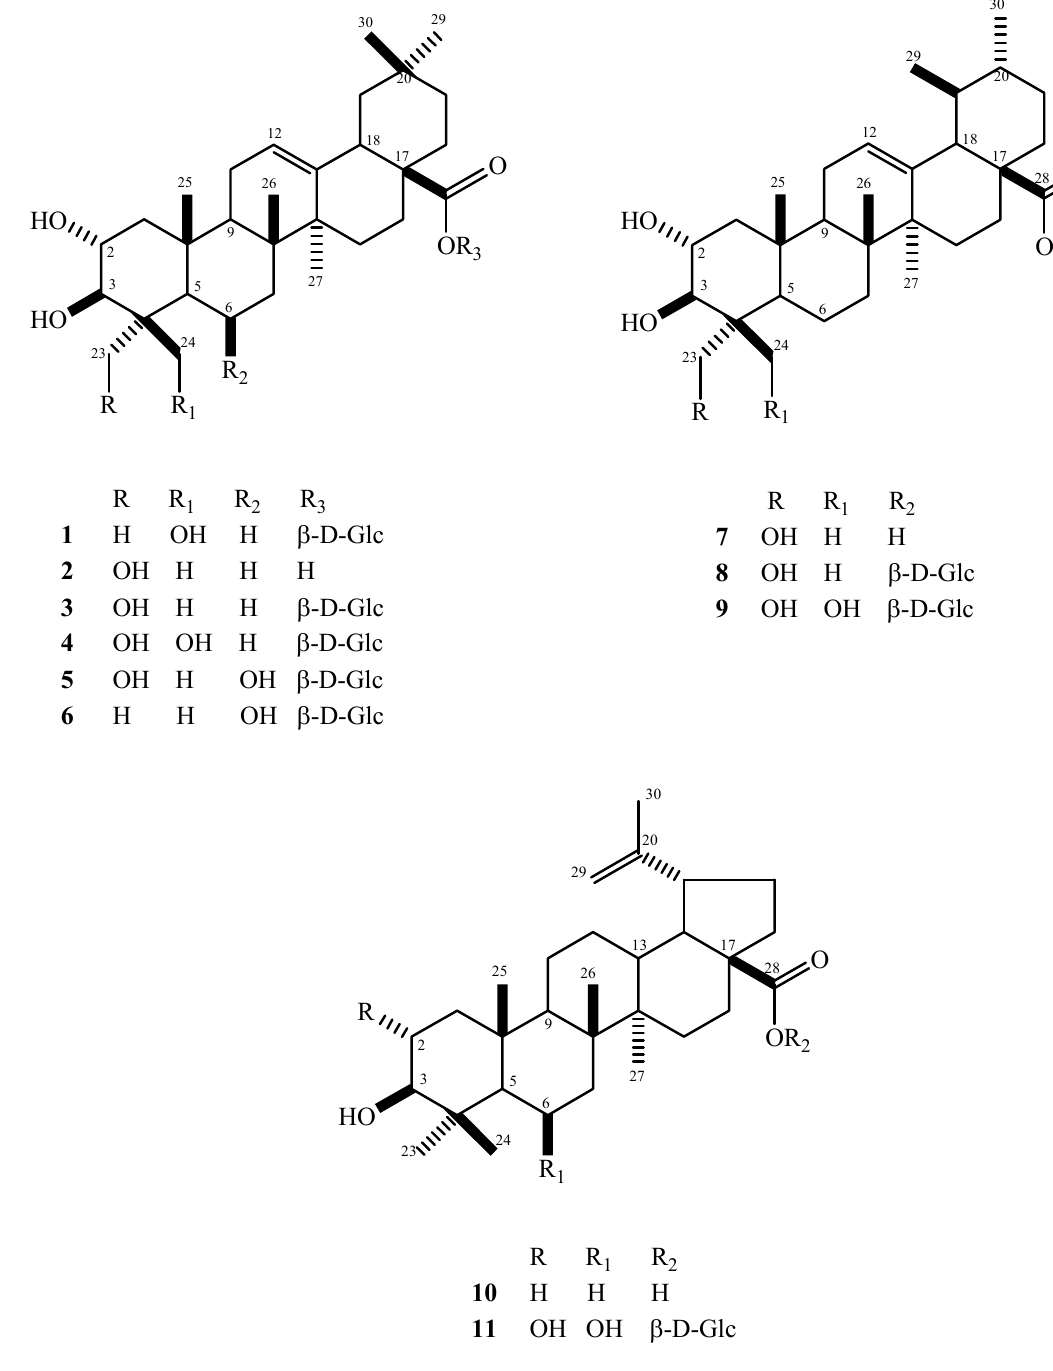
Figure 1. Structures of the triterpenoids 1 – 11 isolated from C.